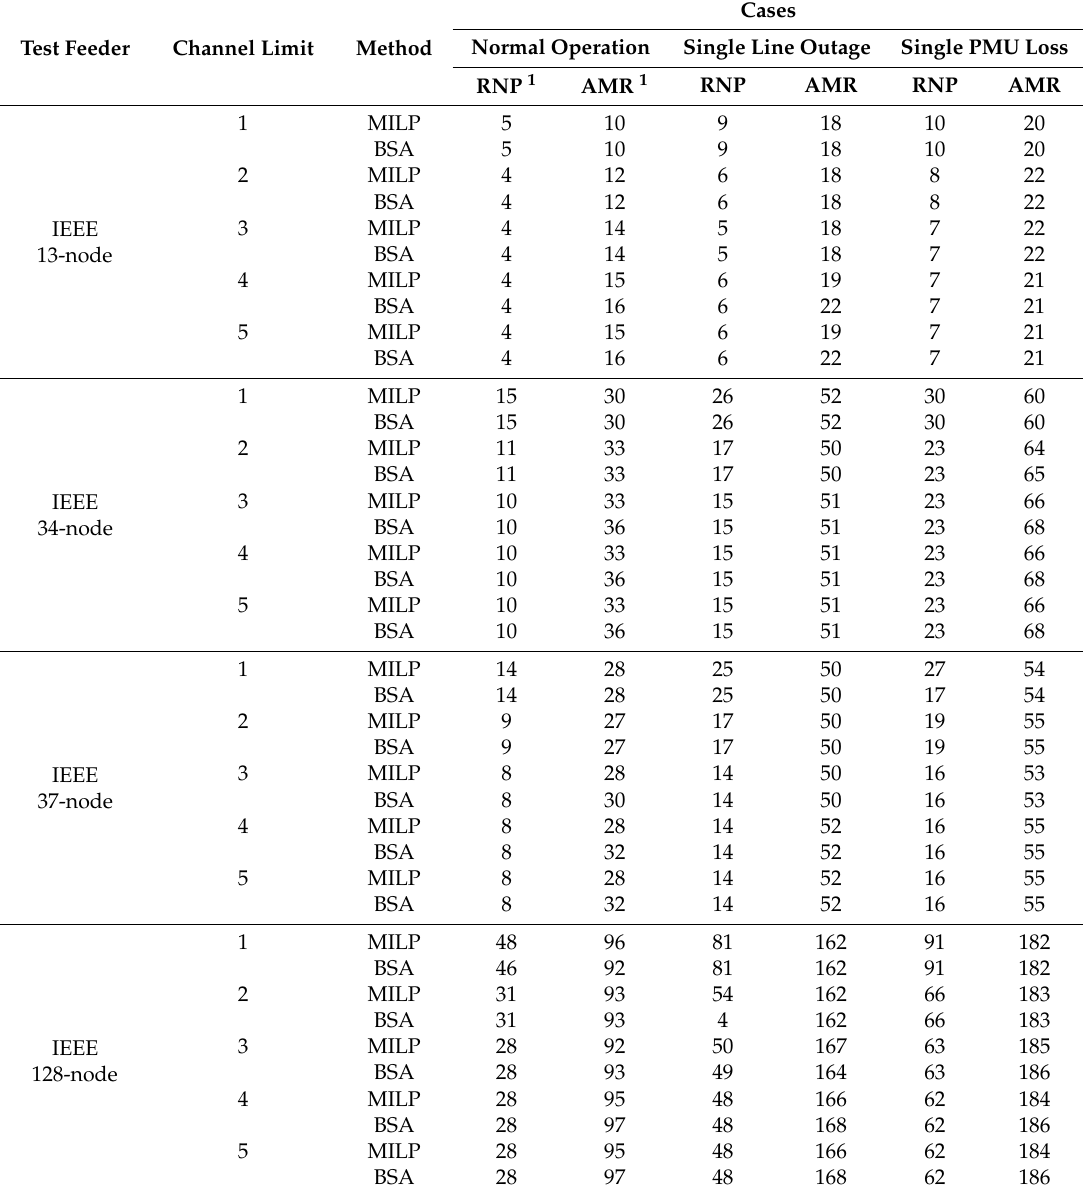
Table 10. Optimal numbers and locations of PMU during normal and contingency cases considering both ZIB and channel